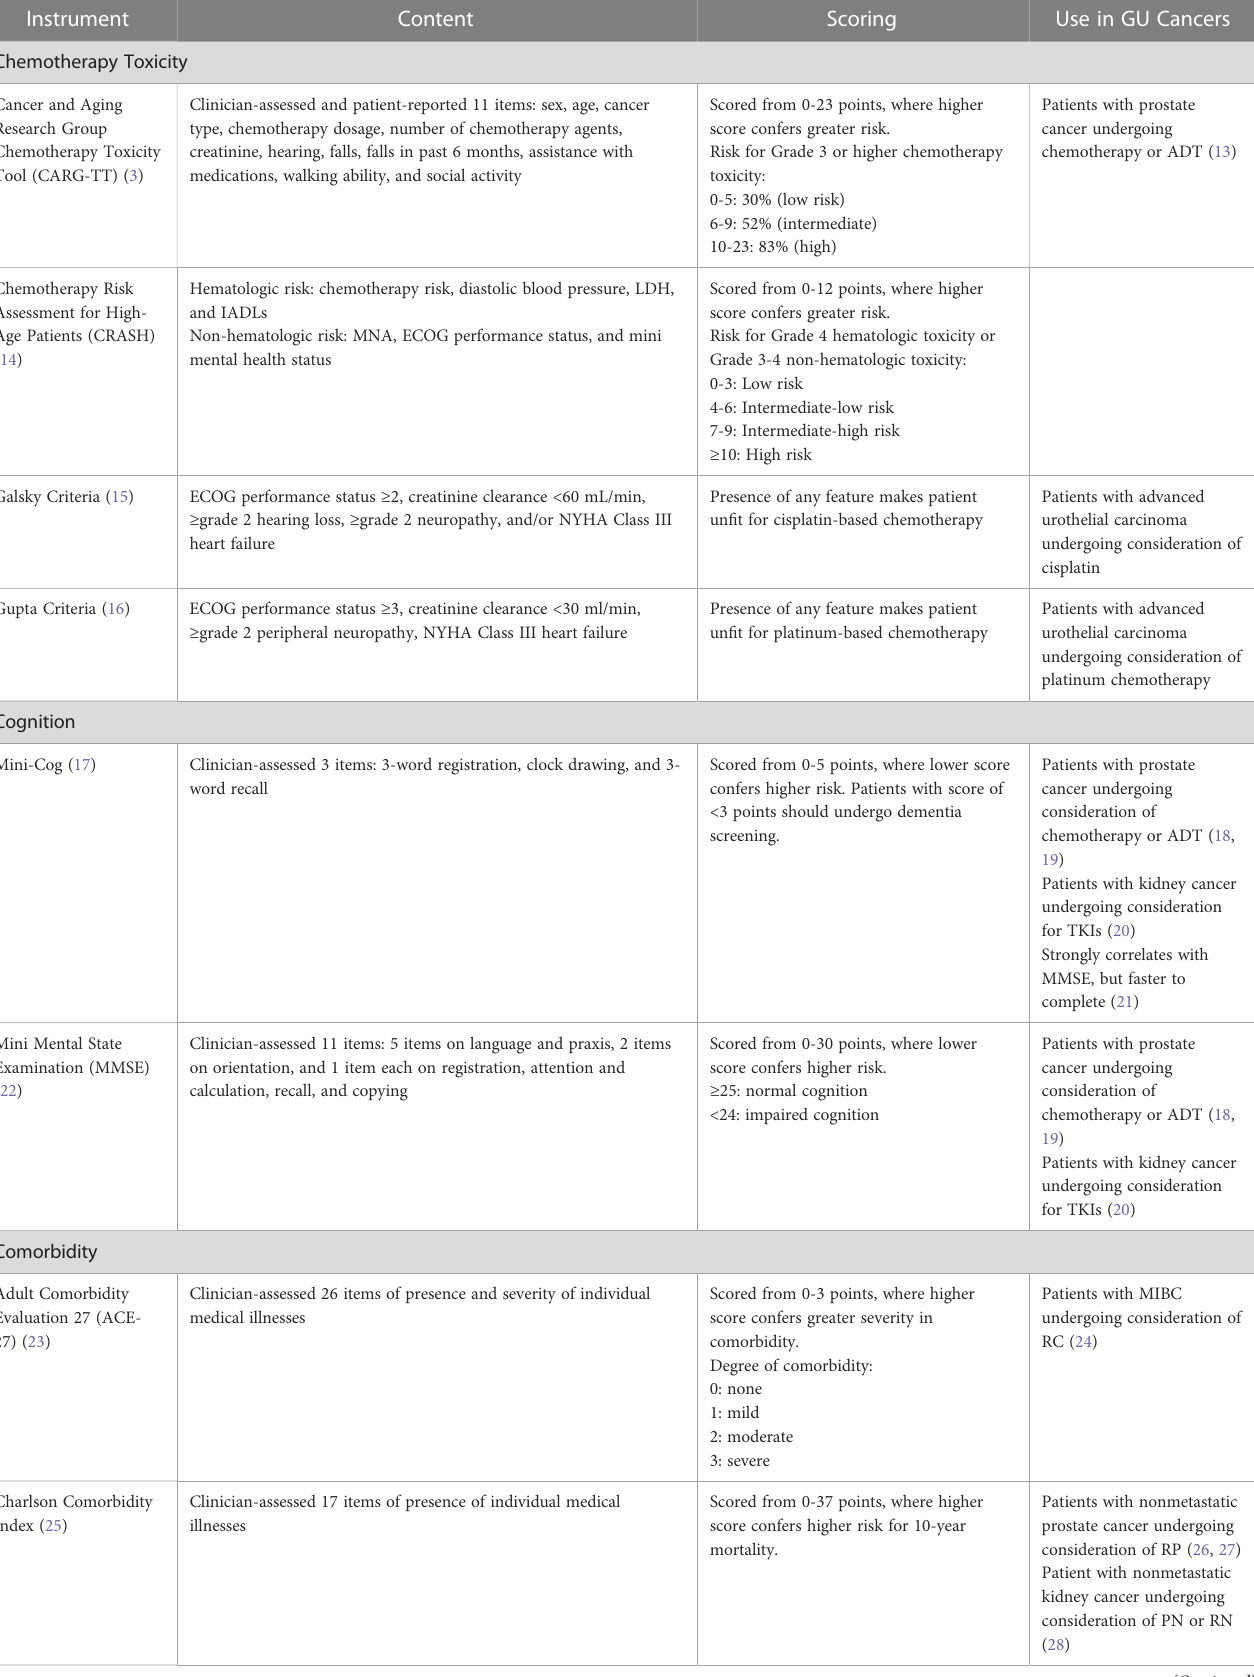
TABLE 1 Exemplar geriatric assessment instruments in genitourinary (GU) cancer. Instrument Content Scoring Use in GU